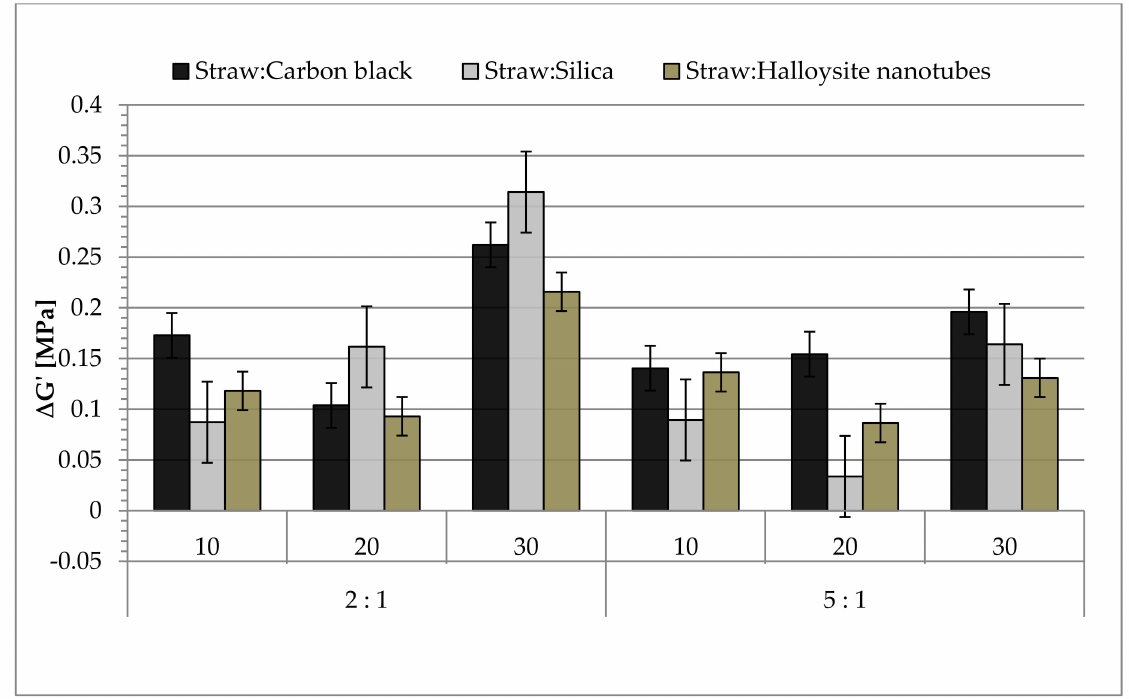
Figure 13. The Payne effect values of filled natural